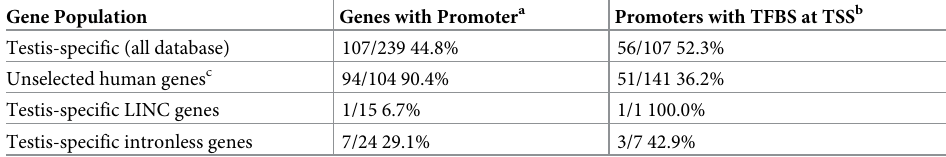
Table 3. Testis-specific genes with a promoter and transcription factor binding site near the transcription start